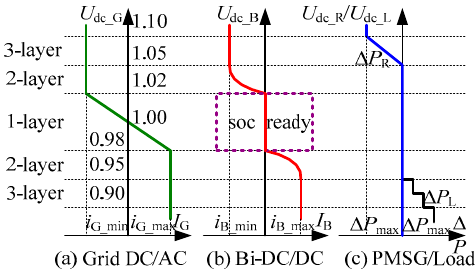
Figure 12. Hierarchical coordinated control strategy.